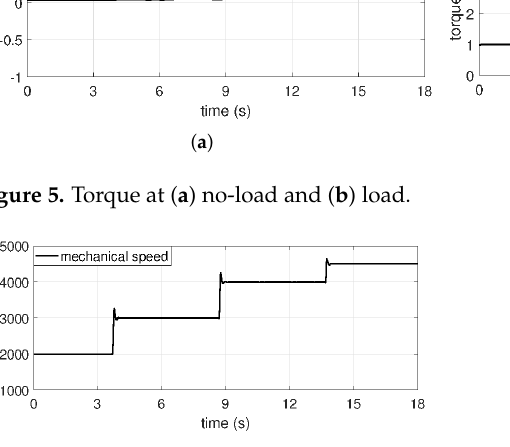
Figure 6. Mechaincal rotor speed.